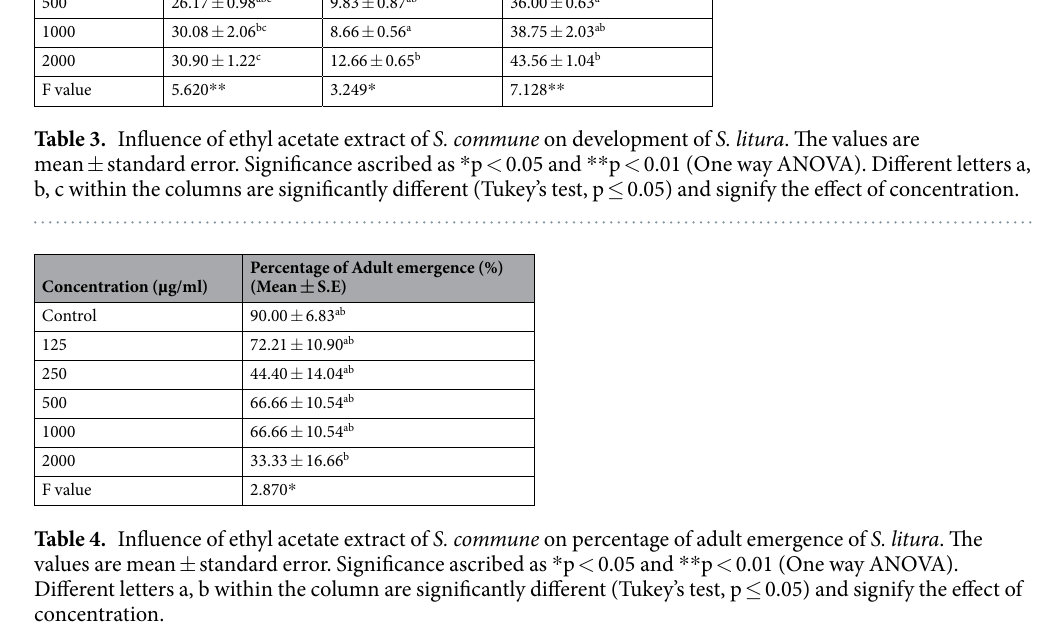
of treatment with ethyl acetate extract of S. commune on lipid peroxidation as indicated by malondialdehyde